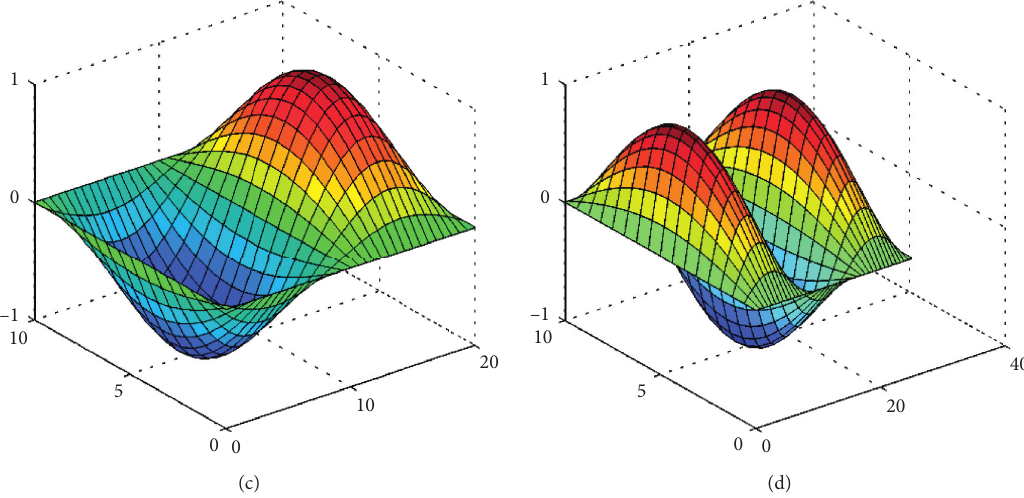
Figure 16: Axial buckling modes of simply supported rectangular plates with various length-to-width ratios: (a) a / b � 1 . 0; (b) a / b � 1 . 5; (c) a / b � 2 . 0; (d) a / b � 2 .